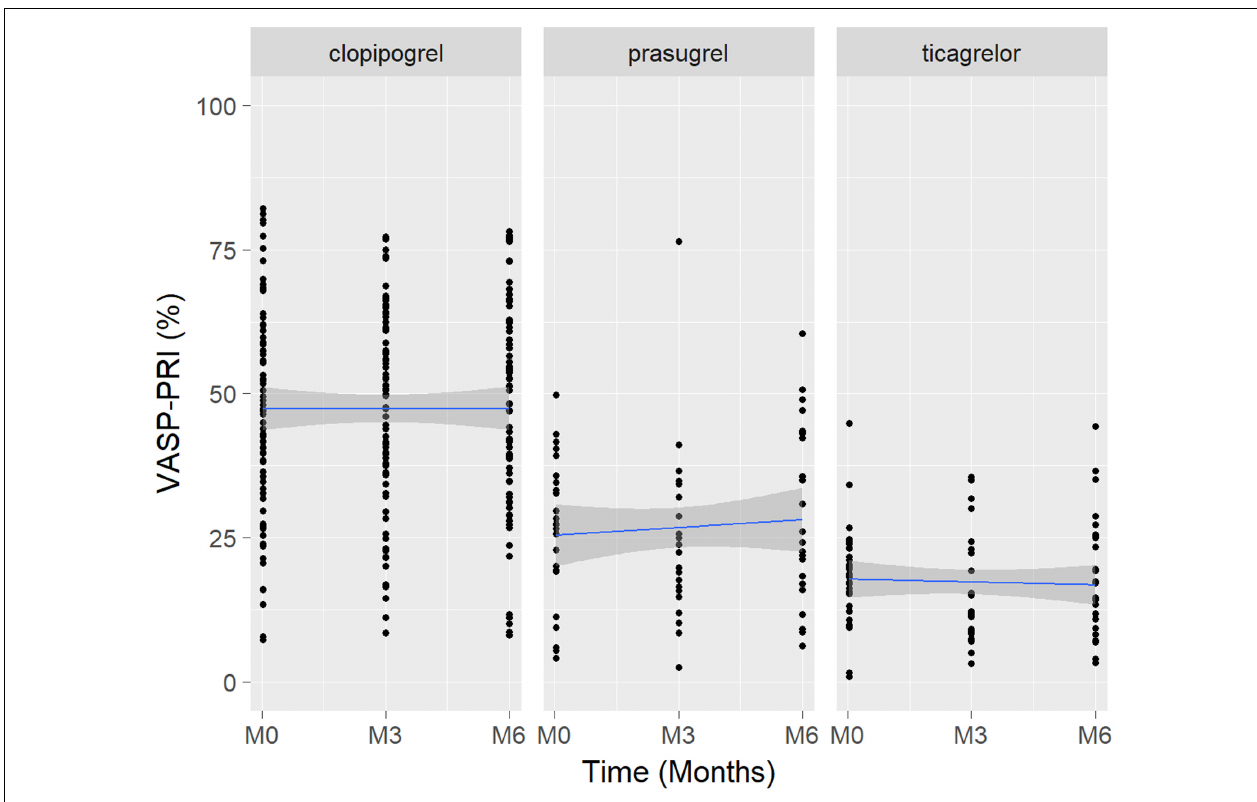
FIGURE 2 | Boxplot of VASP-PRI results over time according to the anti-P2Y12 drug. VASP-PRI, vasodilator-stimulated-phosphoprotein-phosphorylation-platelet-